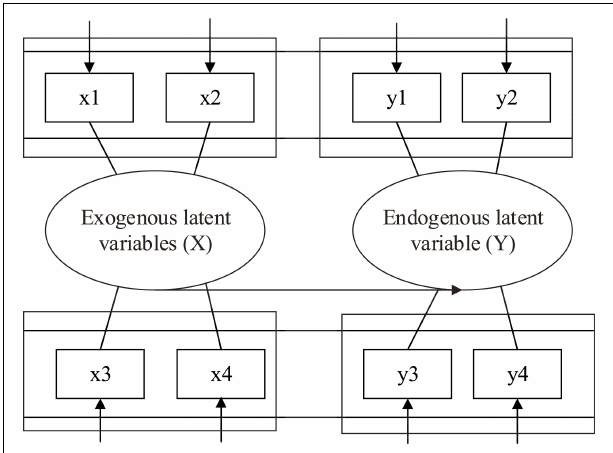
FIGURE 1 | The structure of the structural equation model (SEM).